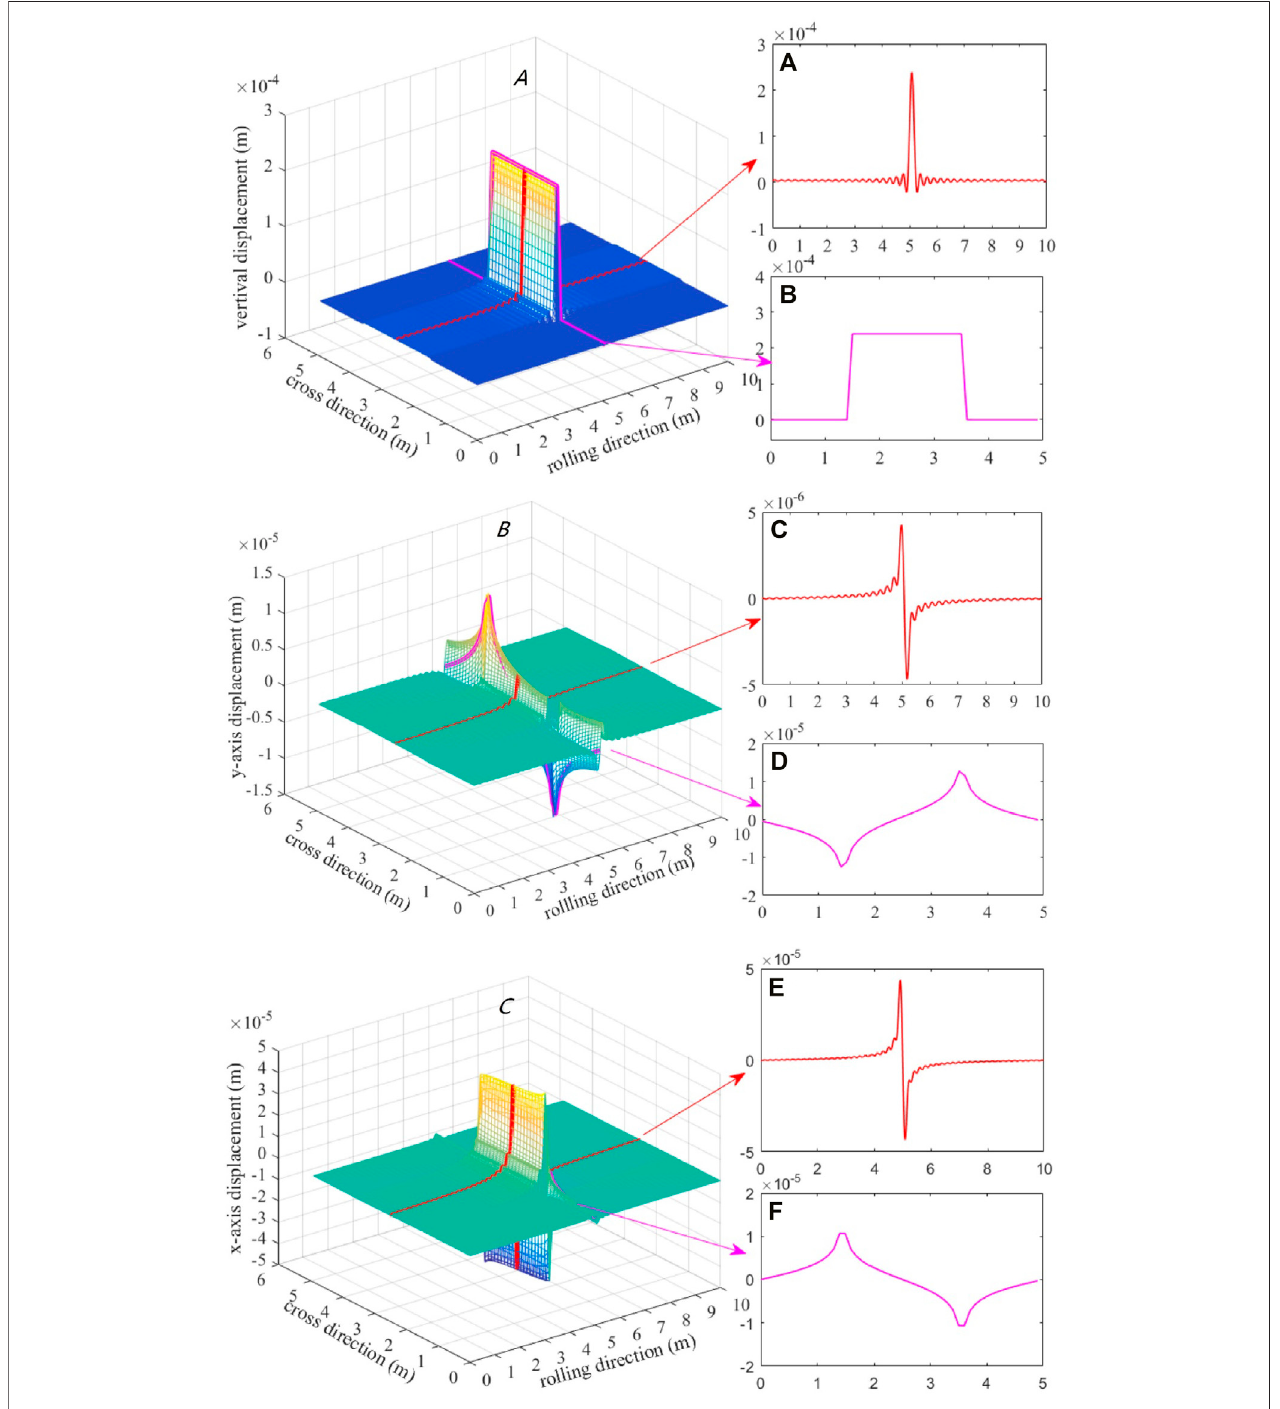
FIGURE 8 | Displacement pro fi le in three directions, (A) vertical; (B) y -axis; and (C) x -axis.